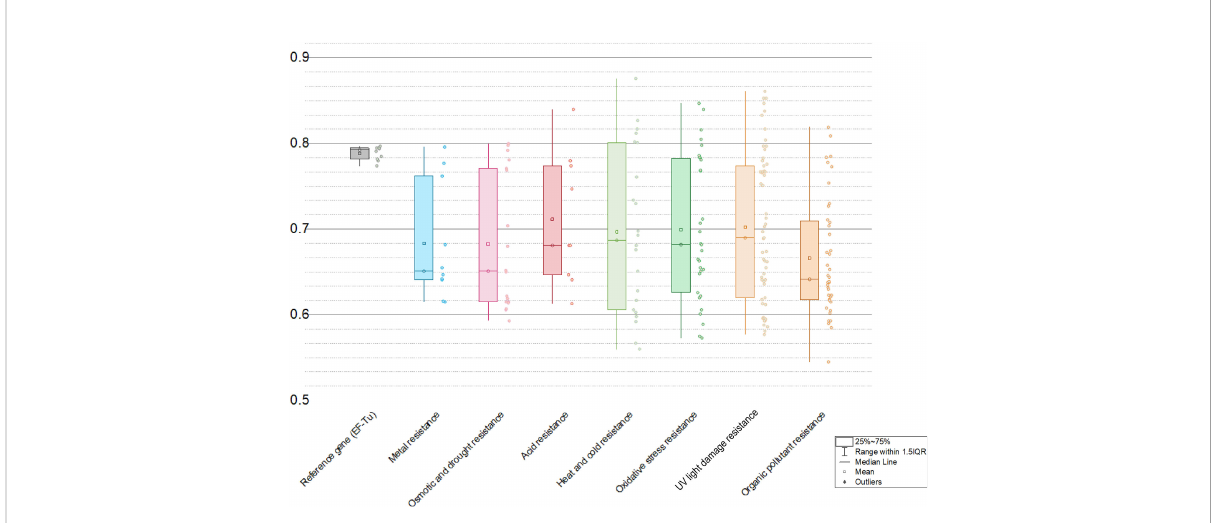
FIGURE 6 Ranges of codon adaption index (CAI) values of different kinds of abiotic resistance genes with EF-Tu gene as a